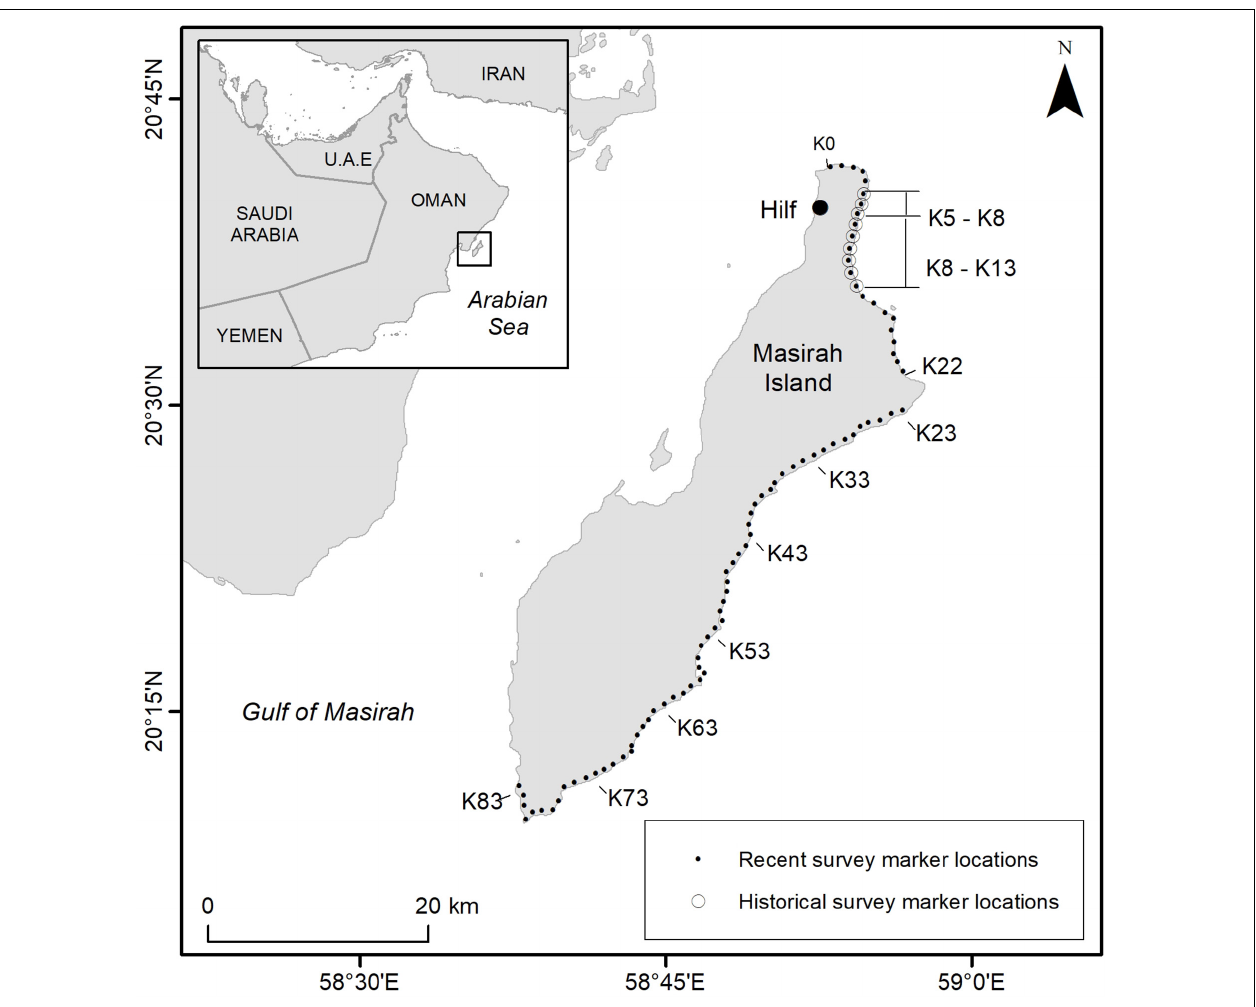
FIGURE 1 | Loggerhead nesting beaches of Masirah Island represented by beach marker locations, situated approximately every kilometer along nesting habitat, (also known as “K” markers). Historical data collected between May and August was performed once per week between markers K5 and K13 (1977–1979), and up to five days per week (1985–1996). Daily counts were performed on K5–K8 (1977–1987). Recent surveys included daily surveys on index beaches between markers K0–K22 and up to once per week on non-index beaches between K23 and K83 (2008–2016). Location coordinates for nesting survey beach markers can be found in Supplementary Table S1